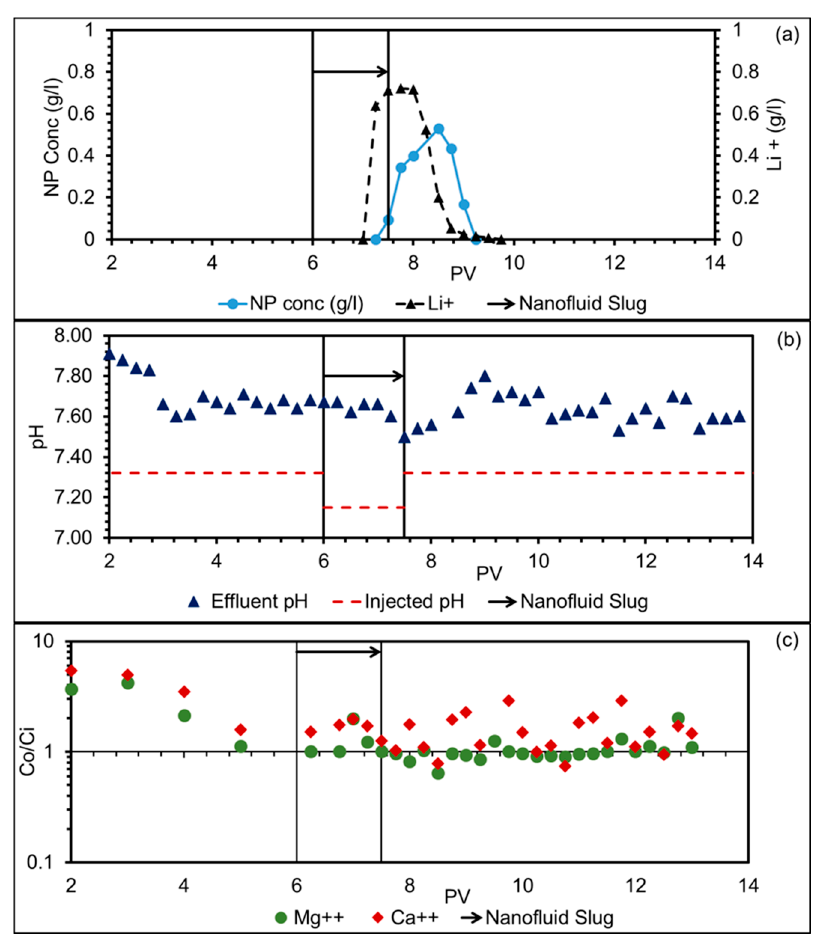
Figure 6. ( a ) NP and tracer concentration profile, ( b ) effluent pH profile and ( c ) effluent Ca 2+ and Mg 2+ concentration for SK4 in LSW.